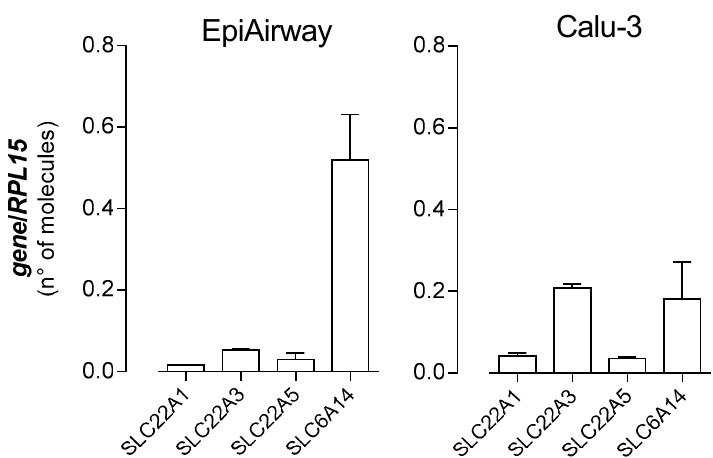
Figure 6. Expression of organic cation transporters in EpiAirway ™ and Calu-3. The absolute quantification of the mRNAs for SLC22A1 / OCT1, SLC22A2 / OCT2, SLC22A5 / OCTN2, and SLC6A14 / ATB 0, + was performed as described in the Material and Methods Section by means of qRT-PCR. The expression of the gene of interest is expressed as number of molecules, upon normalization for the reference gene ( RPL15 ). Data are means ± SEM of four determinations.